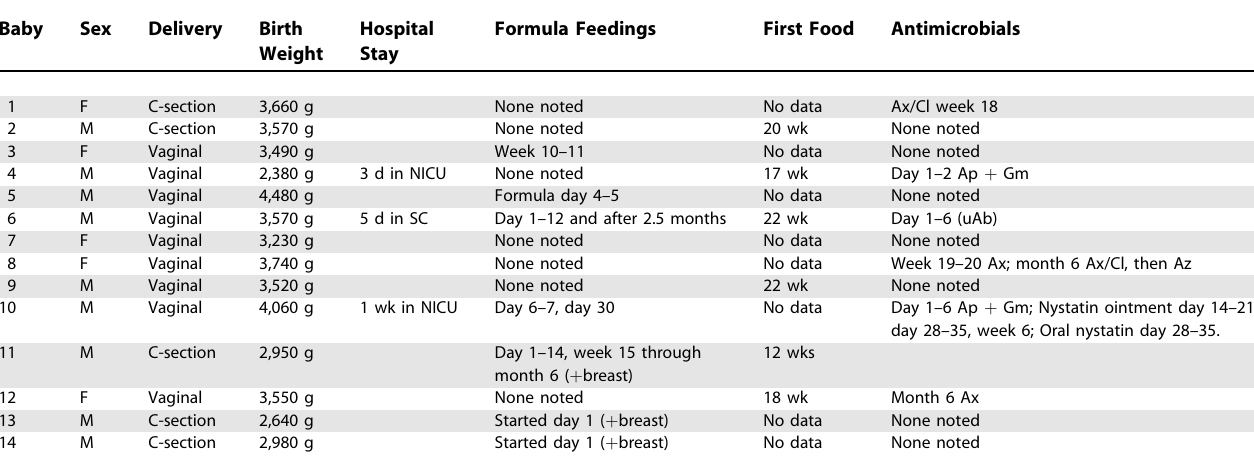
Table 1. Relevant Characteristics of the Infants in This